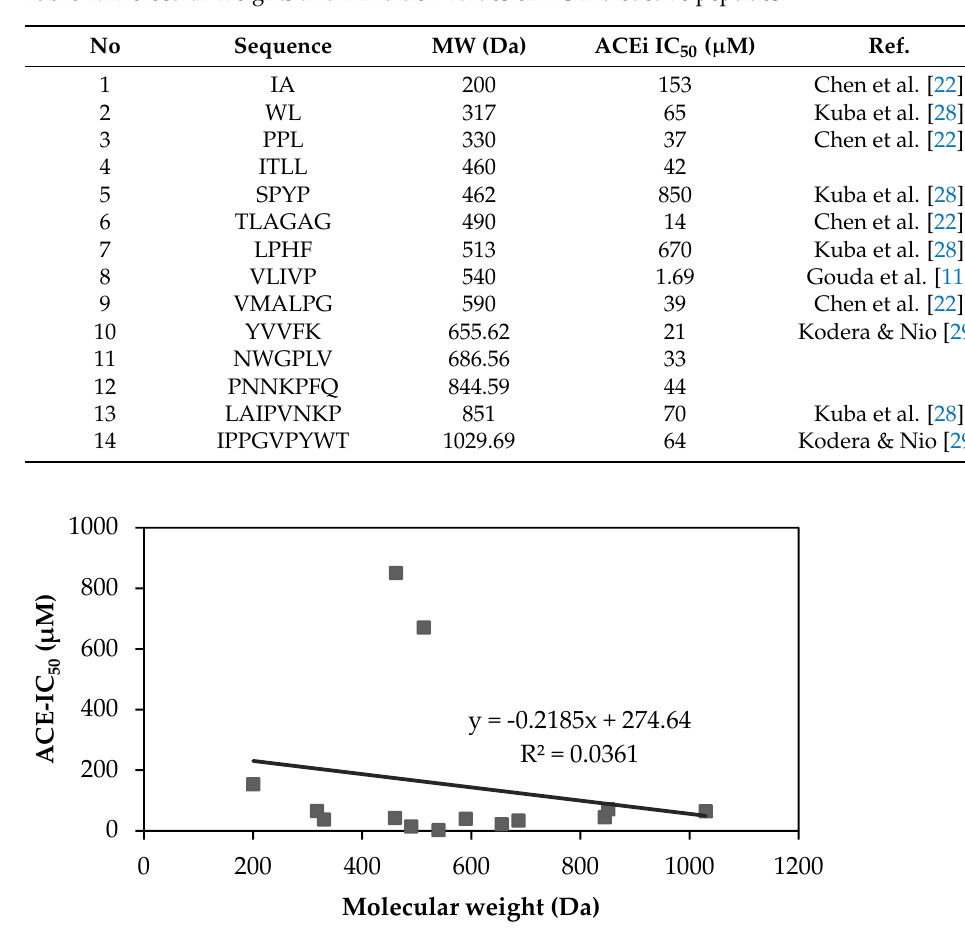
Figure 1. Correlation between ACEi activity and peptide’s molecular weight. MWs and IC 50 values are taken from Table 4.